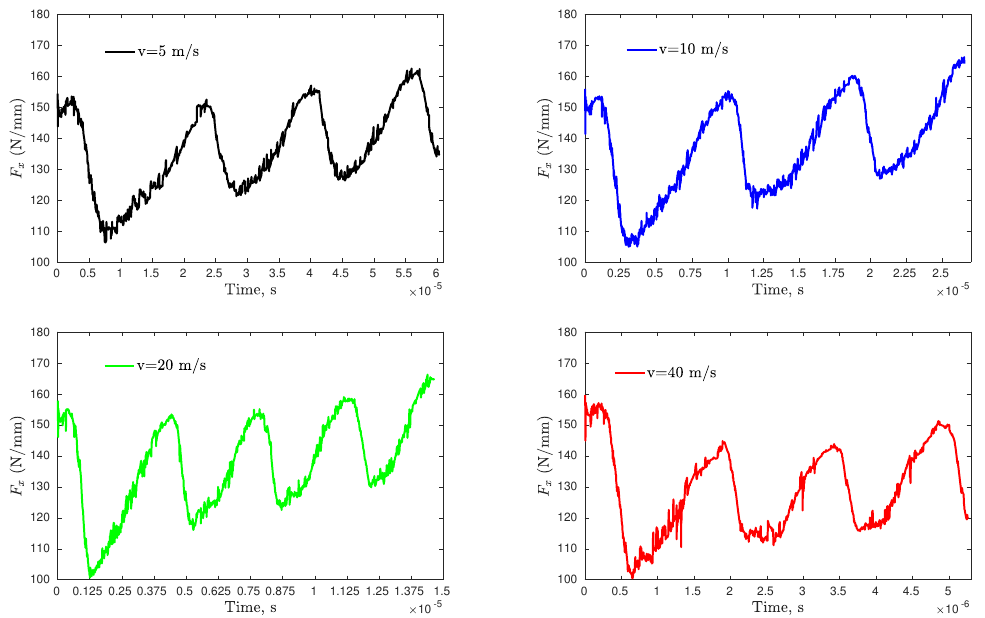
Figure 18. Evolution of the main cutting force F x vs. speed v under thermally aided shear instability (feed = 0.08 mm/rev, rake angle γ = 0 ◦ ).